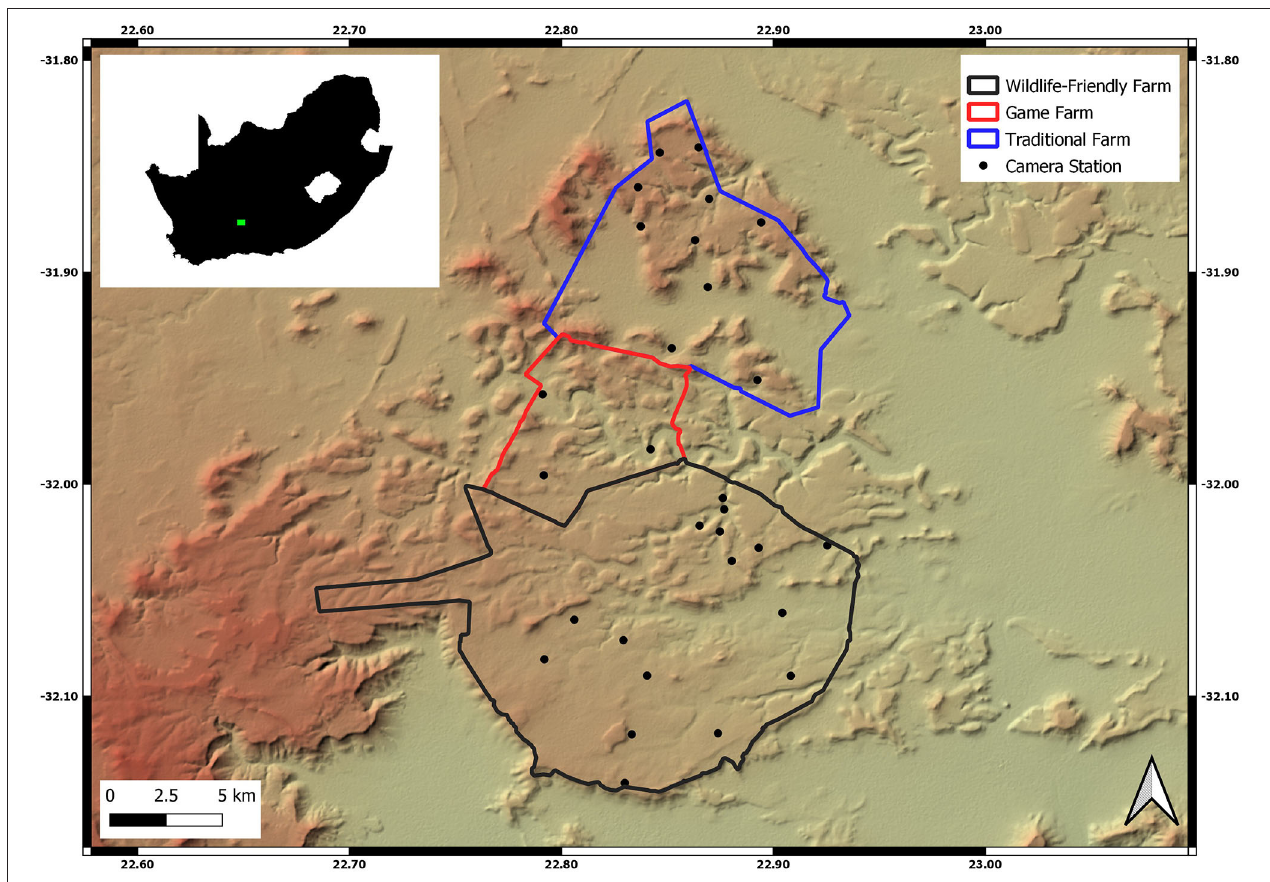
FIGURE 1 | Location of the three study sites, which included the wildlife-friendly farm (black), a game farm (red), and a traditional livestock farm (blue), on a hillshade projection of the Nuweveld Mountain range ( Van Niekerk, 2015). Camera stations retained in the analysis are indicated by black dots. The inset shows the location of the study region (green) within South